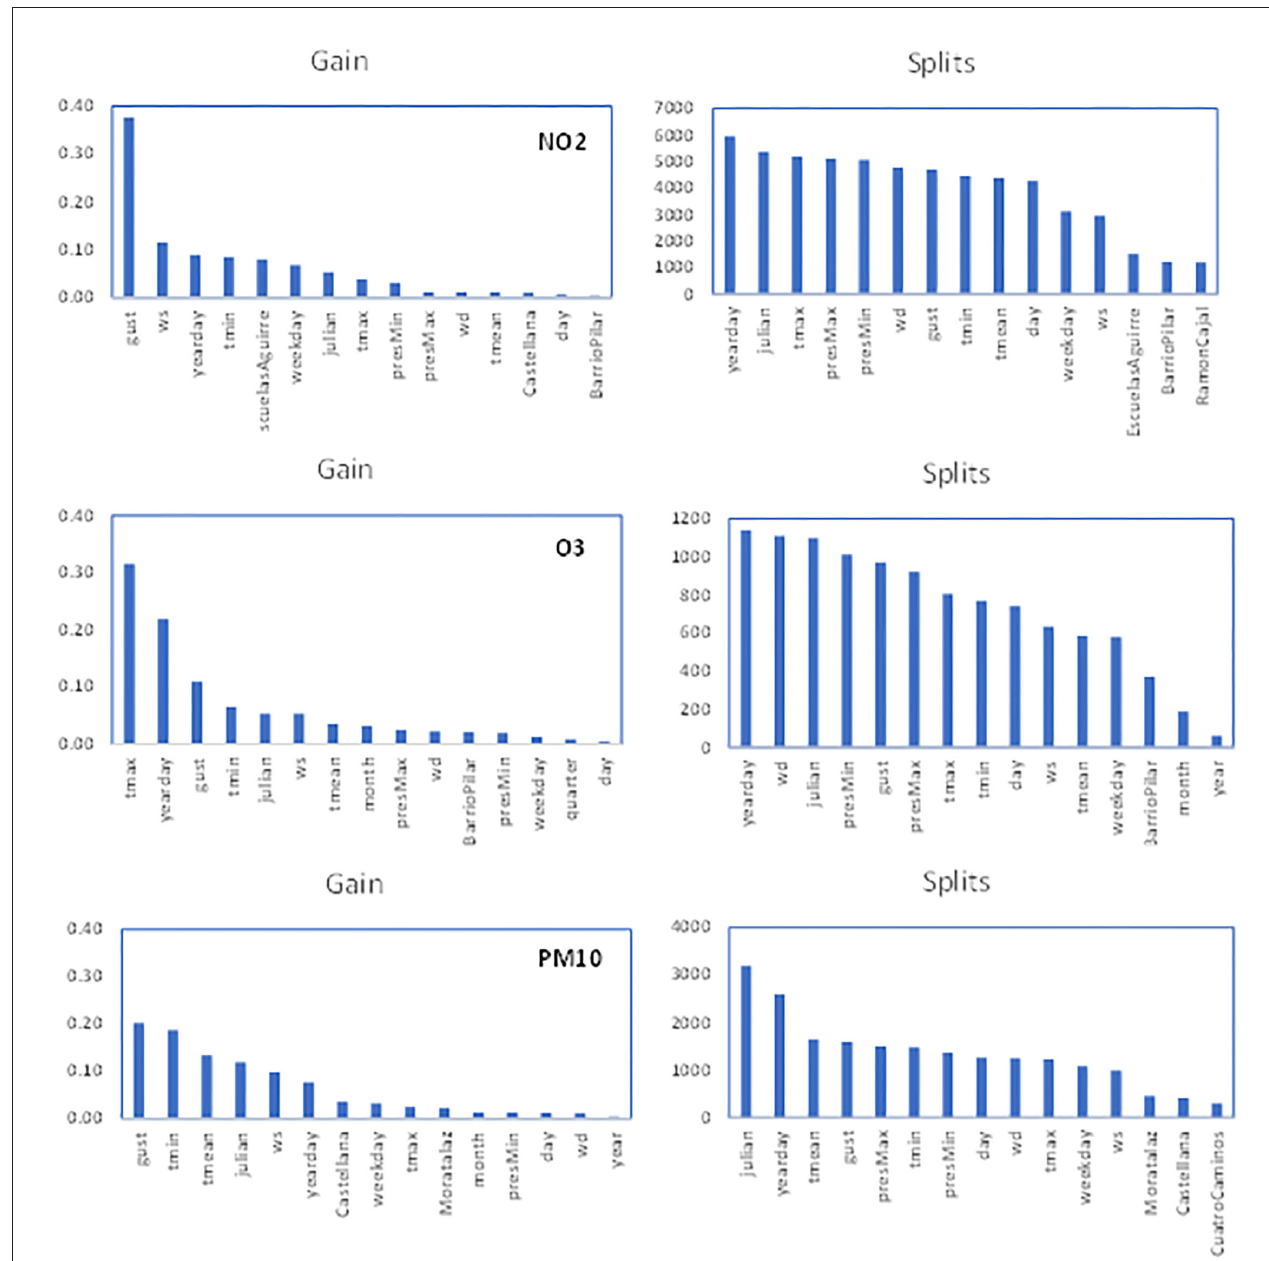
FIGURE 6 | The feature importance bar plots represent the gain for the XGboost model and the number of splits for the LightGBM model and the three pollutants. The results are for the traffic air quality stations (AQSs) using a pool model. complex, highly non-linear, and non-parametric. The obtained results were in line with or better than the results reported by other authors. For instance, Grange and Carslaw (2019) found an r 2 of 0.82, and Falocchi et al. (2021) an r 2 of 0.86 for NO 2 using the RF algorithm. This is a previously developed ML algorithm and is not GBT-based but still gives accurate results. Note that the r 2 was calculated in the training sets, where we obtained an r 2 > 0.90. However, we prefer to use the k-fold cross-validation as it represents the robustness of the